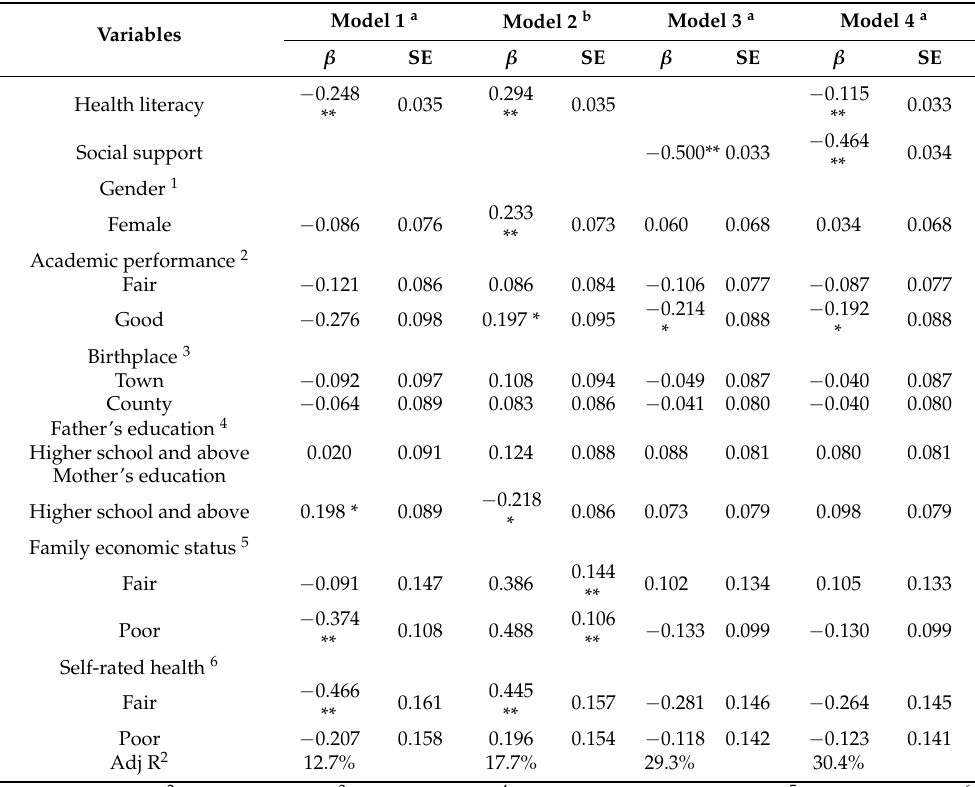
Table 2. Association between health literacy, social support and depressive symptom.